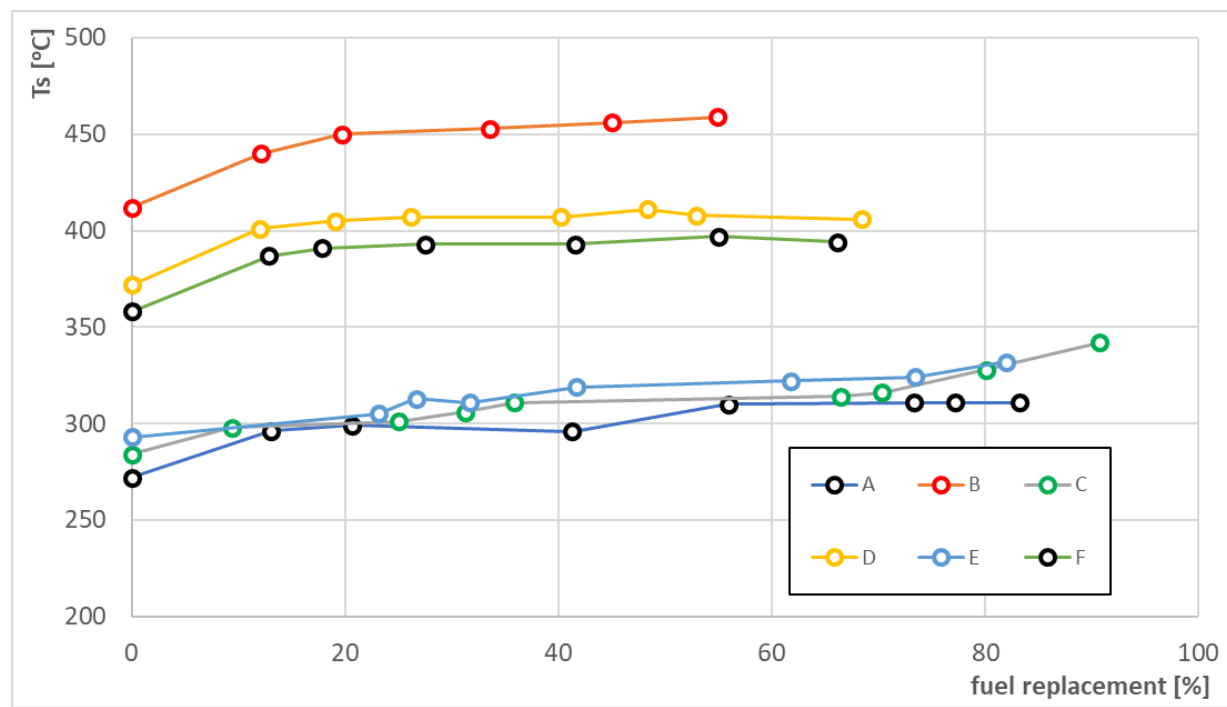
Figure 1. Curves from A to F showing the exhaust gas temperatures for individual engine operating points, where the rotation speed, power, and torque were constant, as a replacement function of diesel fuel replaced by CNG.